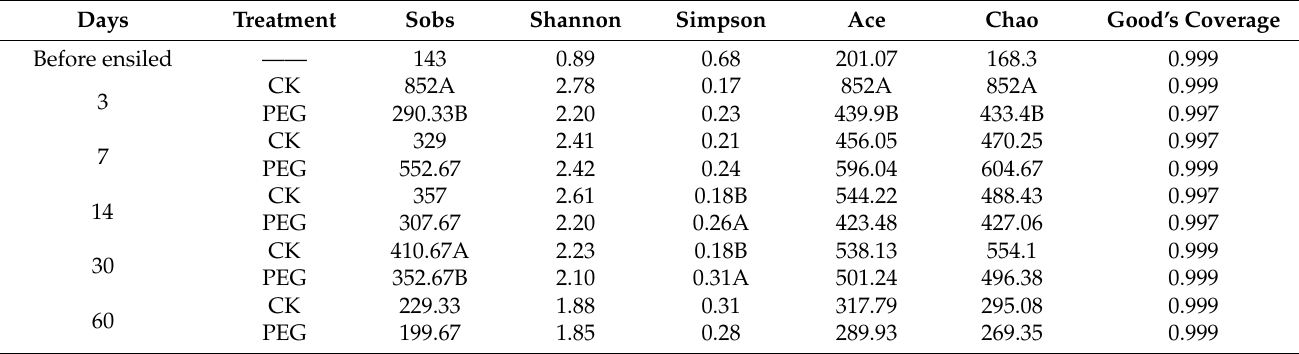
Table 3. Alpha diversity of bacterial community of sainfoin silage 1 .